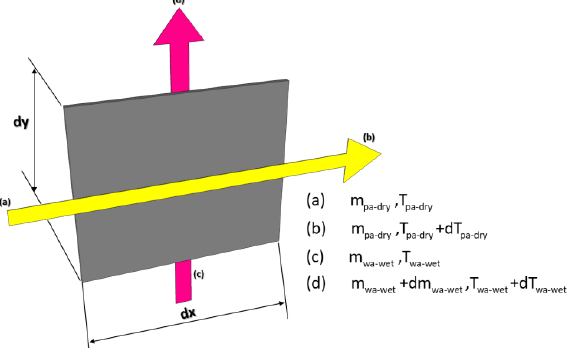
Figure 2. Control volume selected for development of the mathematical model, showing product air channel and working air wet